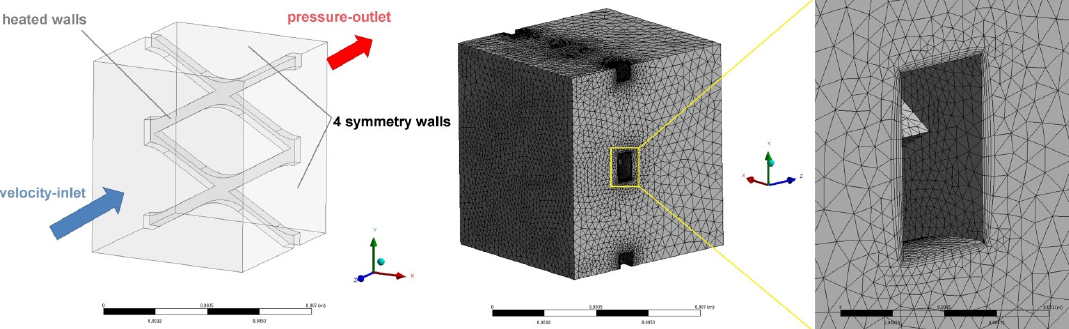
Figure 4. Computational domain for mesh type B with boundary conditions ( left ) and numerical grid ( right ). The sensitivity analysis of the base size of the cells applied in the core of the domain, as well as on the heated wall, was carried out for each mesh type. Table 2 shows the variation of the unit pressure drop Δ P/L and Nusselt number Nu for u 0 = 1 m/s with re- spect to the number of elements for mesh type B. Finally, the fine grid was chosen for mesh type B, as well as for other meshes. Table 2. Grid independency results for mesh type B.